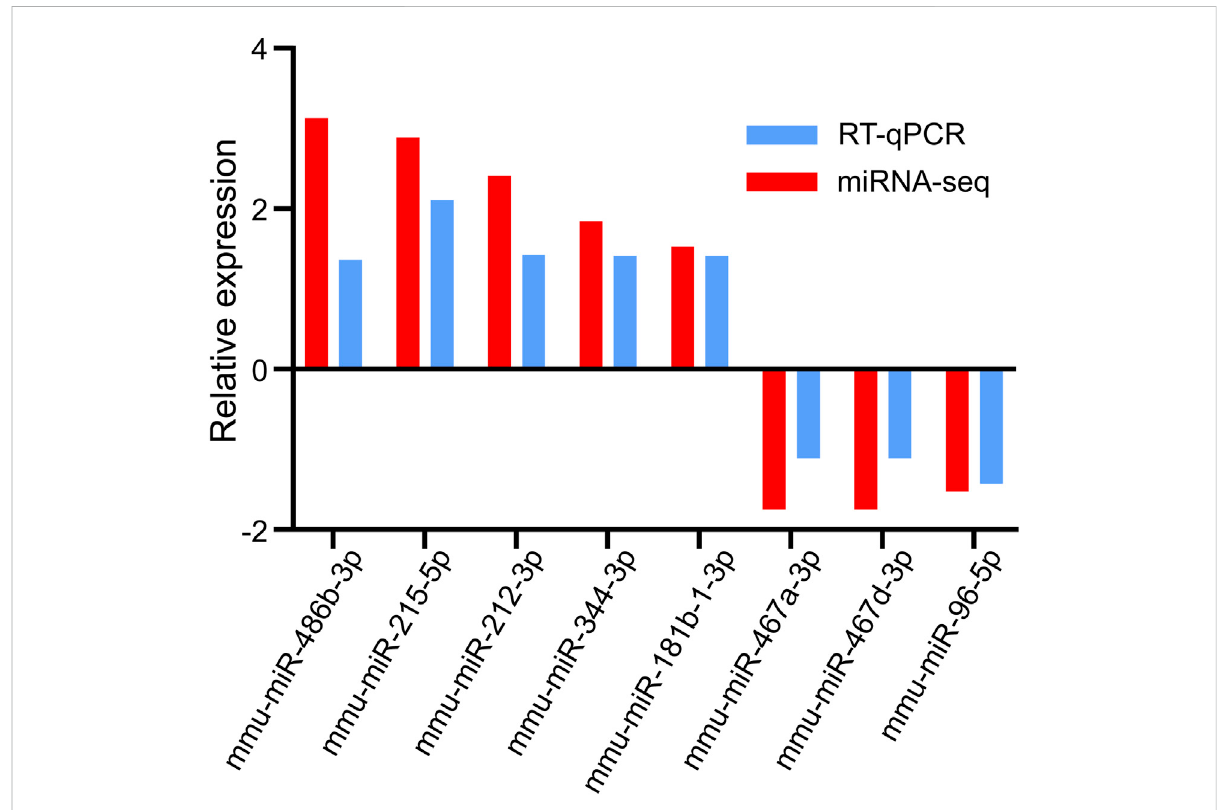
FIGURE 5 Validation of candidate DEmiRs by RT-qPCR. miRNA-seq, miRNA